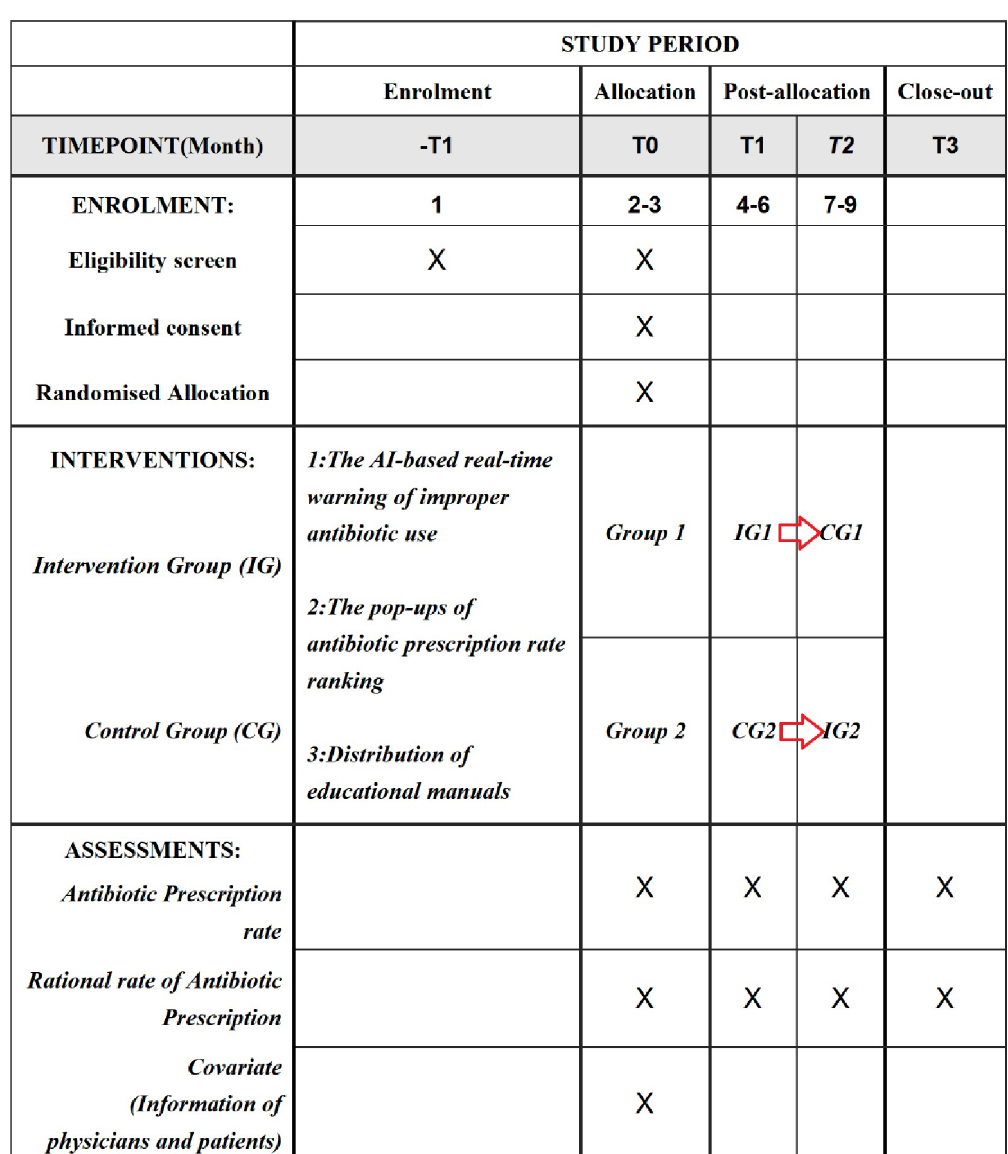
Fig 1. Overview of enrollment, intervention, and assessments of the cross-over design